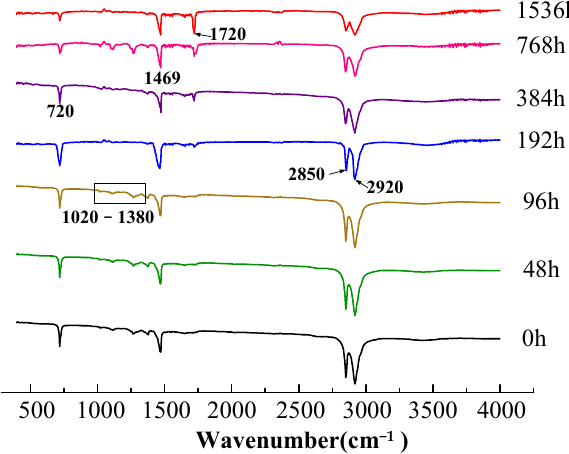
where W XLPE is the crystallinity, I a , I 110 , and I 200 are the diffraction intensity of amorphous, (110), and (200) peaks, respectively.